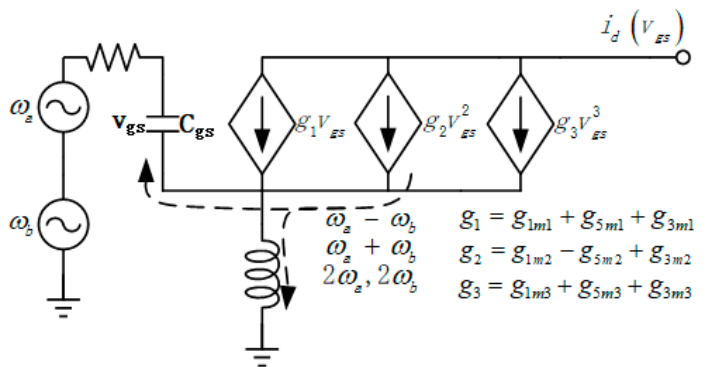
Figure 3. Small signal nonlinear equivalent circuit of the composite MOS (metal oxide semiconductor) in Figure 2b.